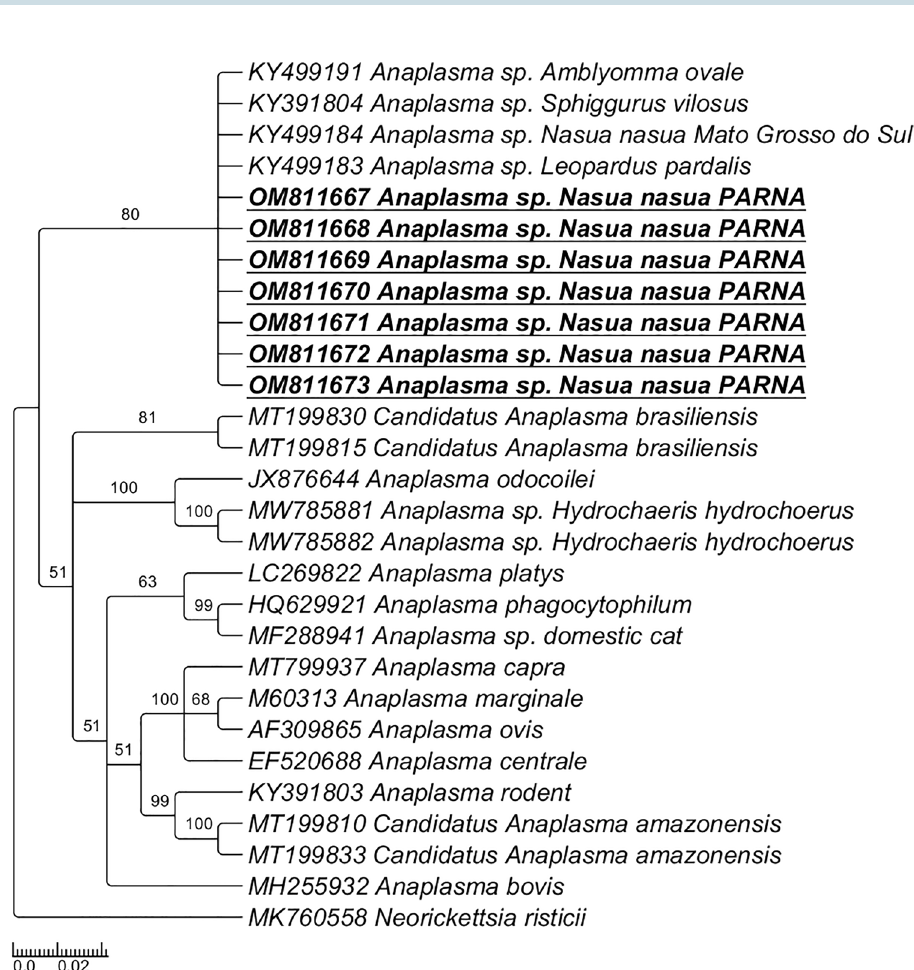
Figure 2. Phylogenetic trees inferred by the Bayesian method and based on 16S rRNA gene from Anaplasma spp. sequences obtained from blood from ring-tailed coatis ( Nasua nasua ) from PARNA. Sequences of Anaplasma sp. detected in the present study are highlighted in bold/underlined. Neorickettsia risticii was used as outgroup.